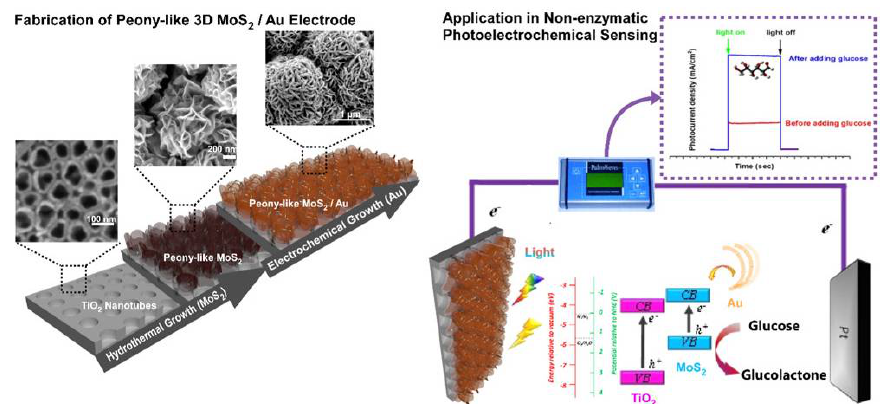
Figure 5. Nanopattern-assisted direct growth of binary MoS 2 /gold electrode and the PEC process for glucose detection by peony-like 3D MoS 2 /Au. Reprinted with permission from ref. [121]. Copyright 2020, American Chemical Society.